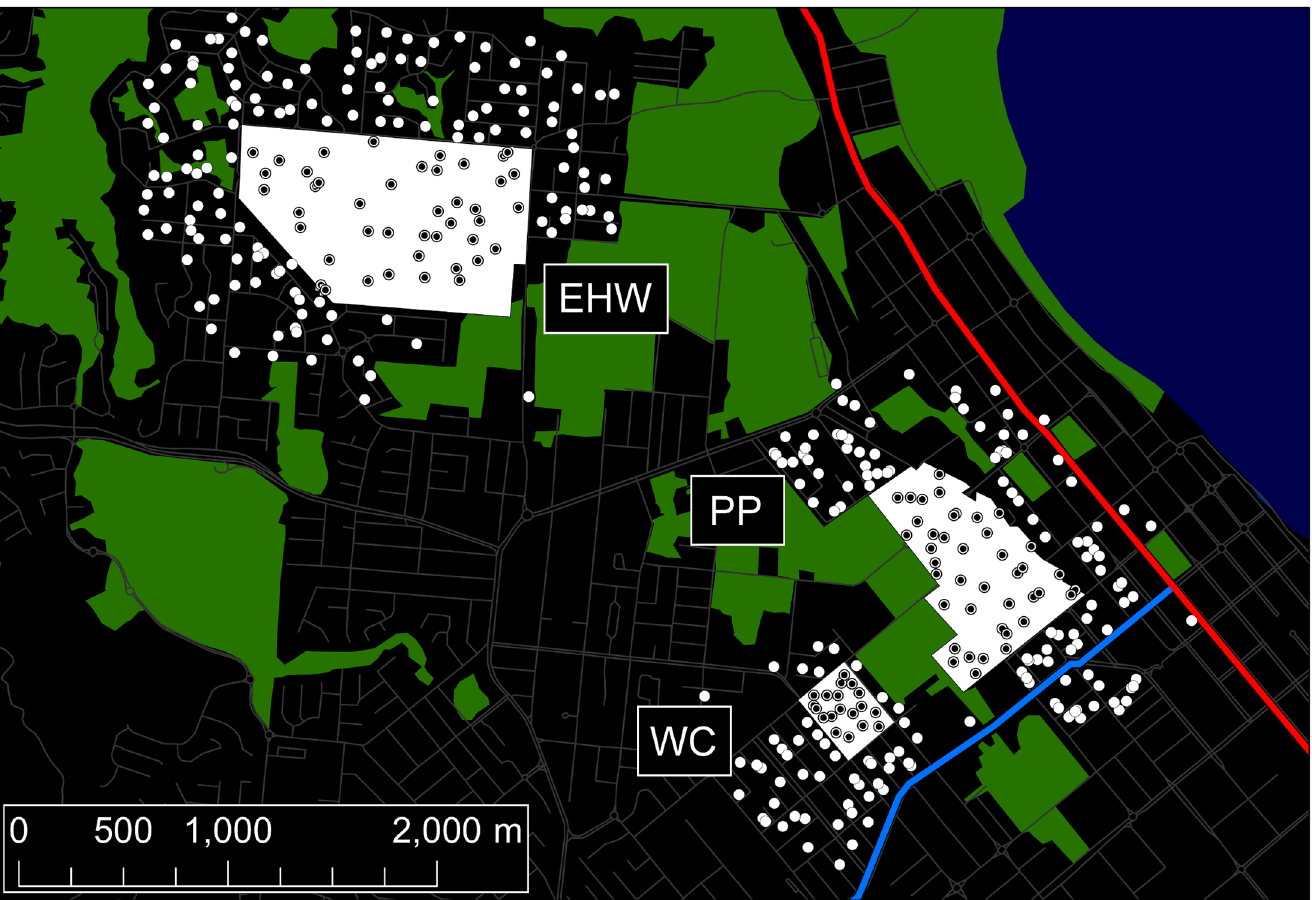
Fig 1. Releasezone locations in Cairns. The 3 releaseareas are Edge Hill/Whitfield (EHW), Parramatta Park (PP), and Westcourt (WC). Locationsof the 2 major highways,MulgraveRoad and CaptainCook Highway, are indicatedin light blue and red, respectively. Locationsof onsite traps (traps within the release zones) are plotted as black dots within white circles, and offsite traps (outside the release zones) are plotted as white circles. (The underlying road network is derived from "AustraliaOceania ContinentRoads," made available by MapCruzin.com and OpenStreetMap.org under the Open